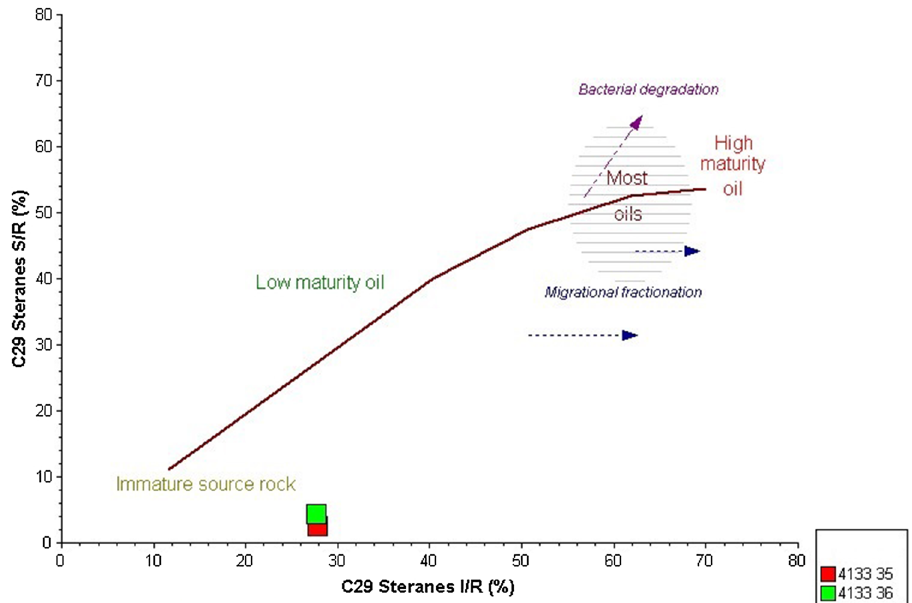
Fig. 11 C29 sterane isomerisa- tion: S/R versus I/R diagram. (4133 35: Turabi Fm., 4133 36: Halıkışlak